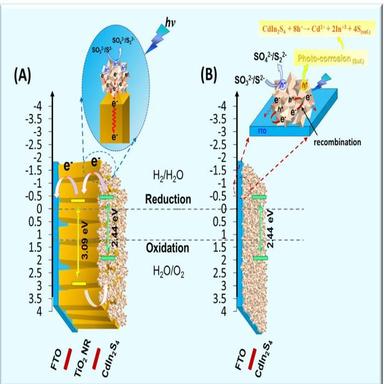
Schematic of the charge transfer mechanism in the CdIS/TONR/FTO heterojunction system. The inset represents the possible photogenerated electrons and holes transfer pathways.